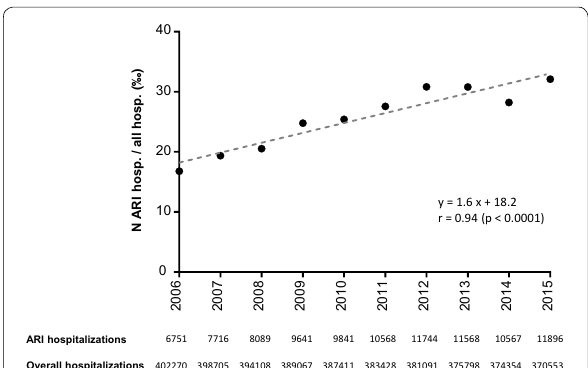
Fig. 2 Ten‑year trends of in‑hospital annual rate of ARI. The in‑hospital annual rate of ARI is the number of admissions for ARI divided by overall admissions (all causes of admission) on the same year period. ARI acute respiratory